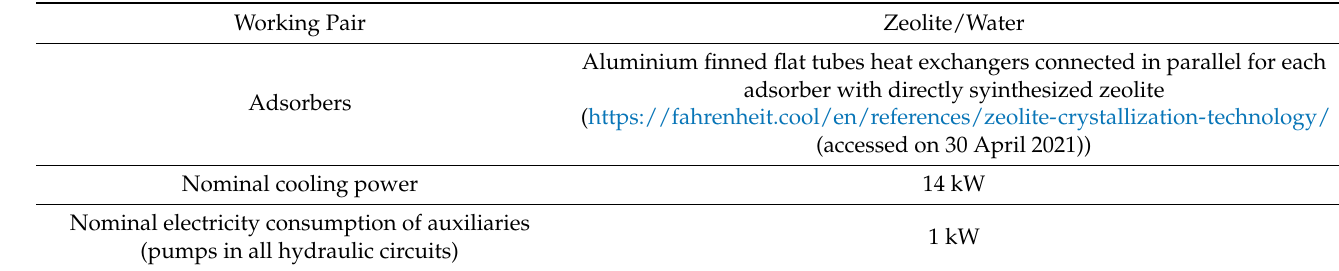
Table A1. Sorption module.